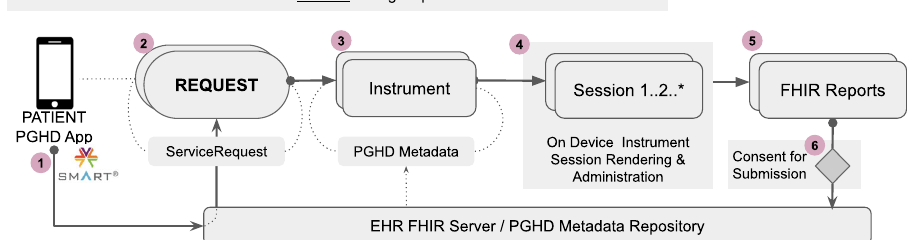
Fig. 5 SMART Markers framework modules for patient-facing app interacting with SMART enabled EHR FHIR server. Data Flow is shown: Patient: (1). Launches a PGHD app connected to the EHR FHIR Server. (2): After logging-in, fetches PGHD related requests. (3): App veri fi es availability of instrument identi fi ed in each request. (4): Begin user session on device and administer the instrument. (5): Generation of FHIR formatted results. (6): User consent for submission of reports to FHIR